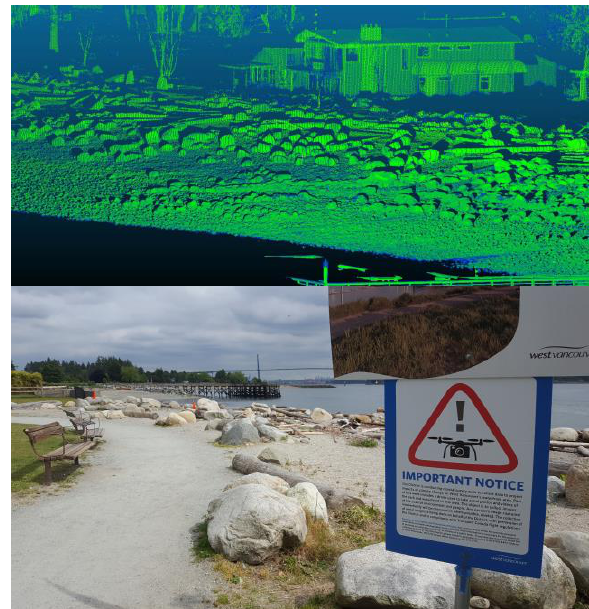
Figure 1. Images from our data survey campaign. Top: view of raw point cloud captured during terrestrial laser scanning of intertidal beach environment. Bottom: in partnership with local municipality and with authorization from federal aviation authorities, we conducted airborne imaging, which we processed using Structure-from-Motion methods. Images from airborne surveys described were processed using Agisoft PhotoScan Professional (V1.4.0). Dense point clouds erroneous points and high-polygon count meshes were created as 0.012 meters, and the derived digital elevation models (DEM) has resolutions of as fine as 0.032 meters.